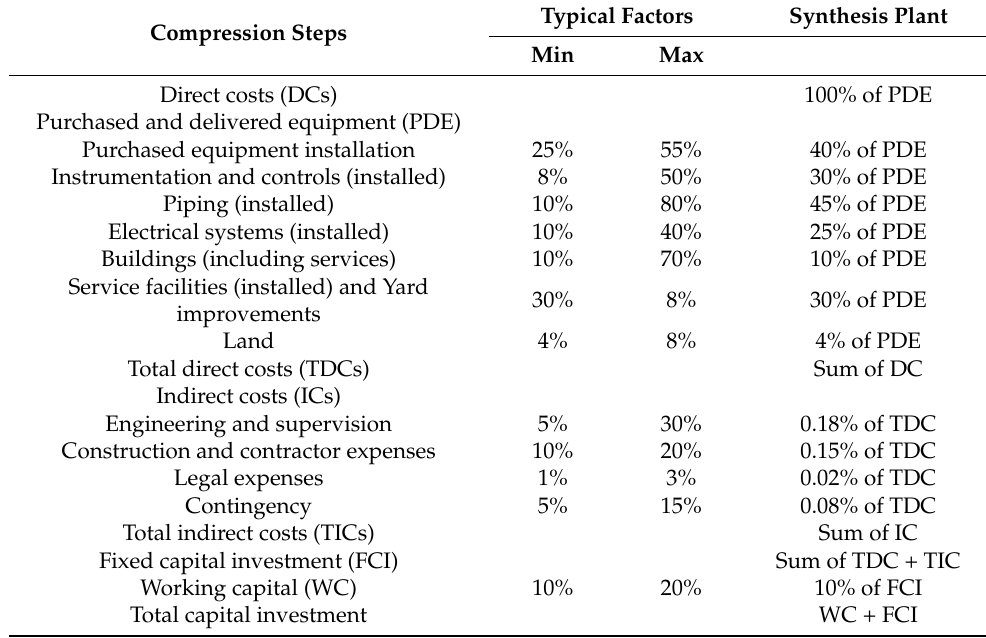
Table 5. Total capital investment